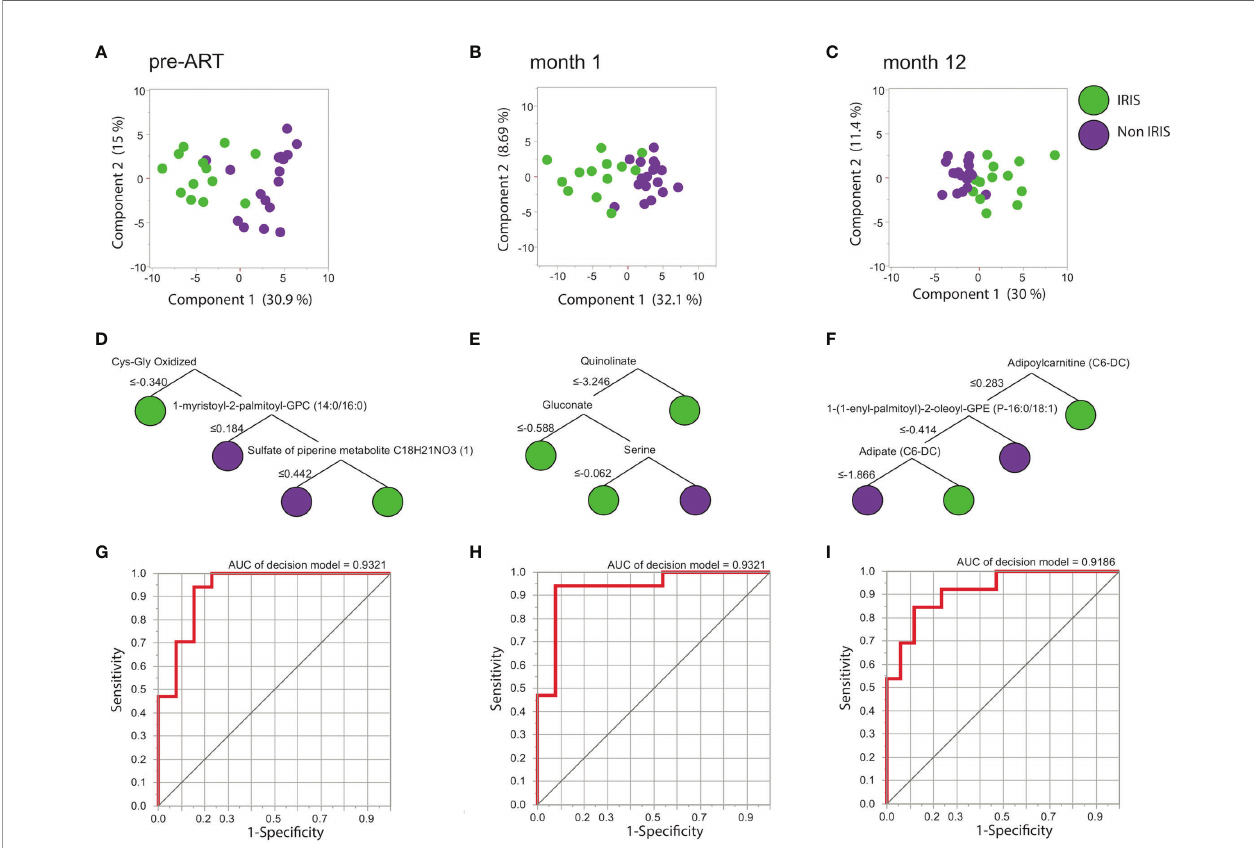
FIGURE 2 | Differentially expressed metabolites (DEMs) prediction of IRIS. Identi fi ed DEMs are analyzed using PCA for the pre-ART (A) , month 1 (B) , and month 12 (C) time points. Decision tree models of the predicting metabolites are shown for the pre-ART (D) , month 1 (E) , and month 12 (F) time points. ROC analysis illustrating the decision tree discrimination power is shown in (G) , (H) , and (I) for the pre-ART, month 1, and month 12 time points